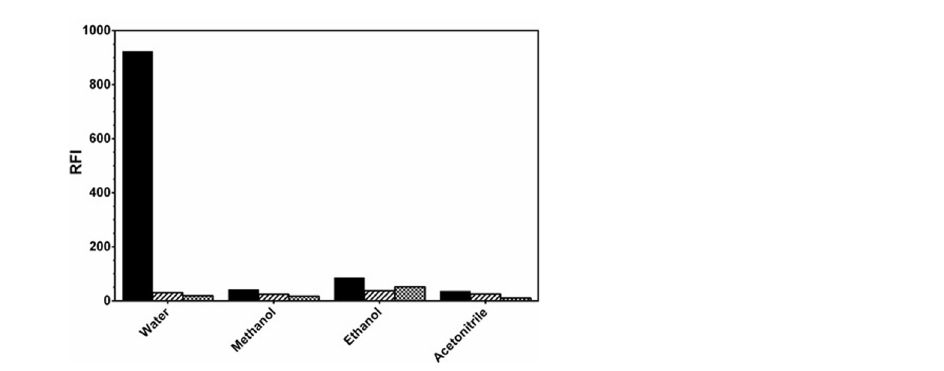
Fig 8. Effect of diluting solvent on the RFI values of the interaction mixture of LAP (1000 ng/mL) with kolliphor RH 40 (2%, w/v). Dotted bars: kolliphor RH 40, stripped bars: LAP, solid black bars: mixture of LAP and kolliphor RH